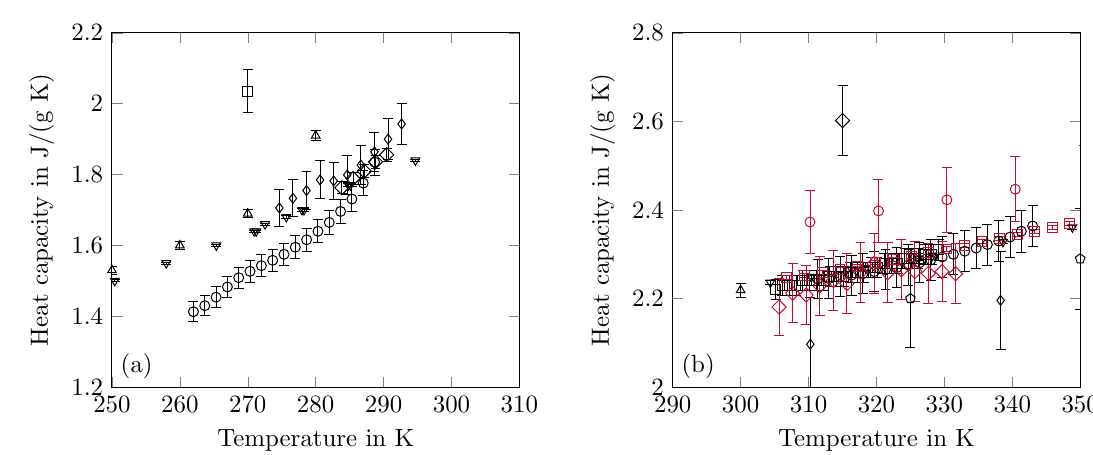
Figure 3. Summary of heat capacity data from the literature in the solid ( a ) and liquid ( b ) state. The error bars are the specified uncertainty of the data. The displayed data of Vélez et al. [27] and of our own research (OR) are reduced to every tenth and fourth point of the available results,